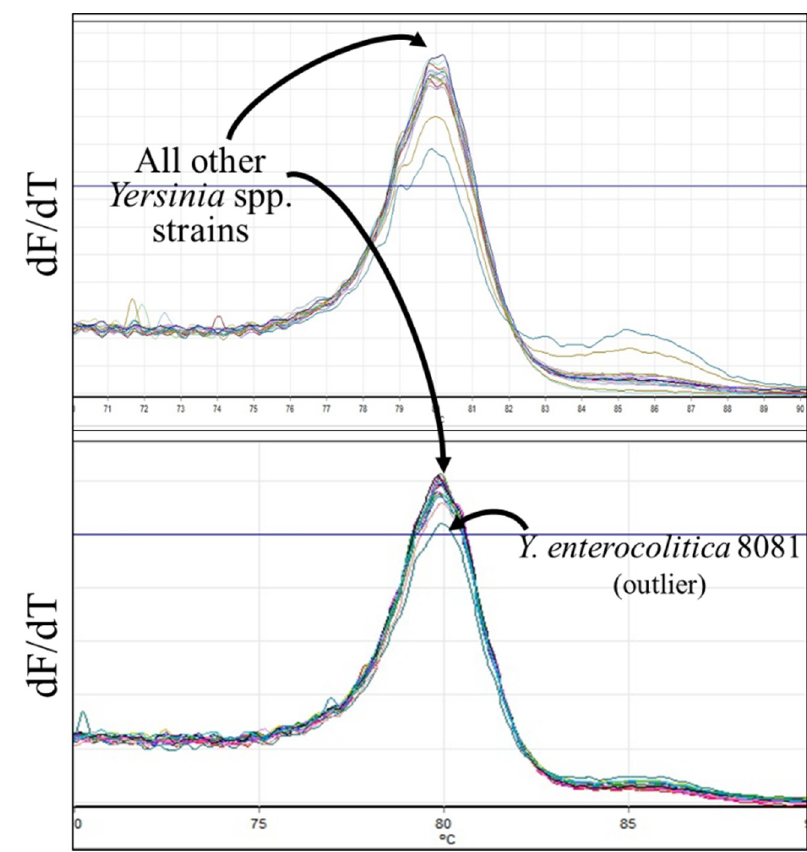
Figure 6. Melt curves for Yersinia spp. gyrA . All samples, independent of species, had melt curve profiles with T m s centered around 80.0 °C (panels show results obtained on different days). The melt curve for the outlier Y. enterocolitica 8081 is shown on the lower curve; there is no obvious feature responsible for its clustering outside of all other Yersinia spp. strains tested.